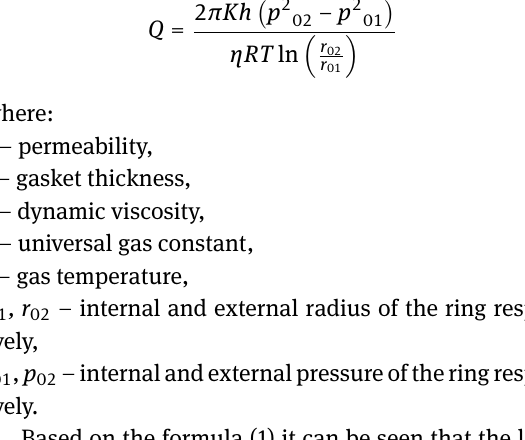
Accordance in the gasket’s model presented in Fig. 15 it can be assumed that the increment x 01 will be caused enlarging of the radius r 01 , whereas increment x 02 will be causeddecreasingofradiusr 02 .Dependingonthegasket’s radii location, three basic cases will be taken to consider-